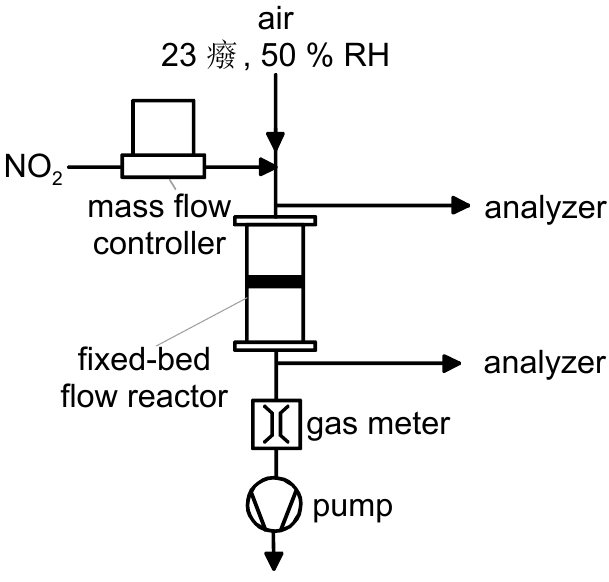
Figure 1. Sketch of the test device for breakthrough experiments.